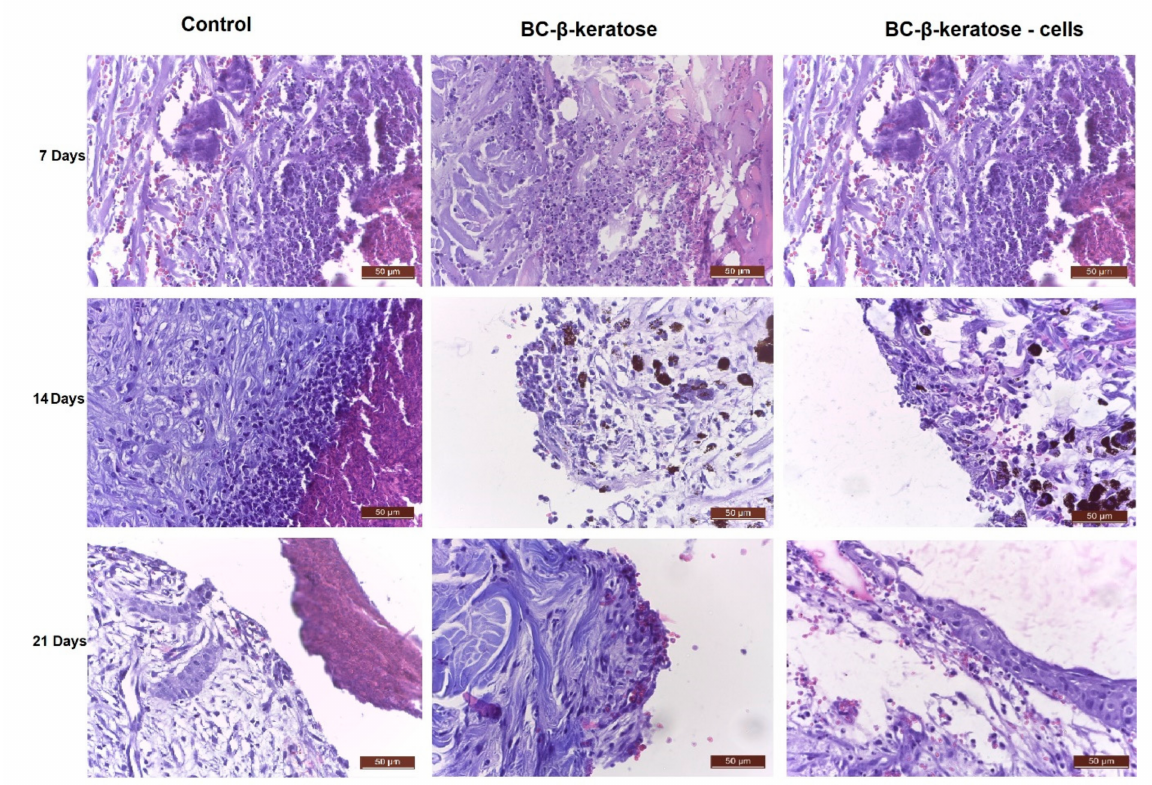
Figure 9. Microscopic images of the stained histological sections (trichrome Masson staining) made on the tissues at different times after grafting (7 days, 14 days, 21